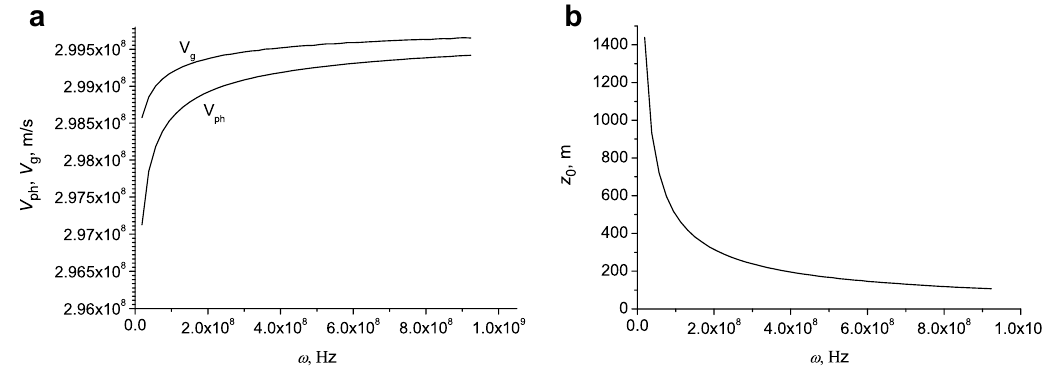
Figure 8. Phase and group velocity ( a ), and attenuation length ( b ) as function of frequency.